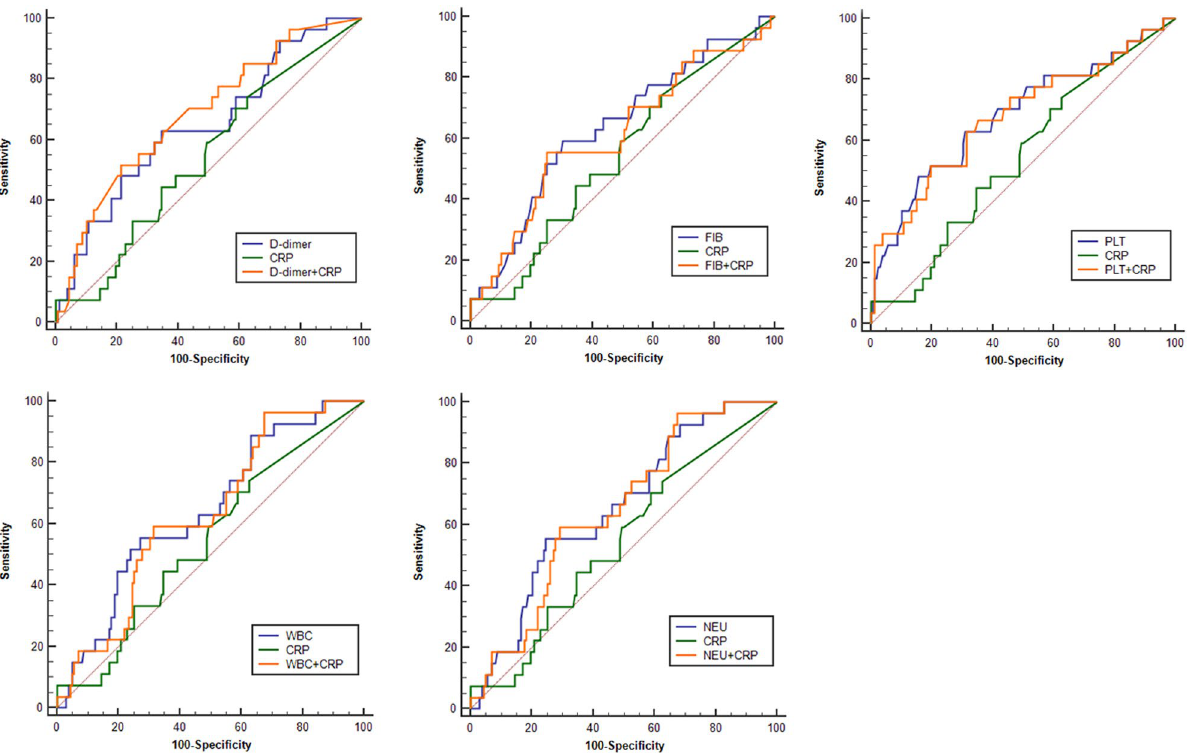
Figure 2. ROC curve of a single index of D-dimer, FIB, PLT, CRP, WBC, or NEU, and the combination of the single index and CRP for predicting in-hospital deaths in patients with type A AAD. ROC, receiver operating characteristic; FIB, fibrinogen; PLT, platelet; CRP, C-reactive protein; WBC, white blood cells; NEU, neutrophil; AAD, acute aortic dissection.